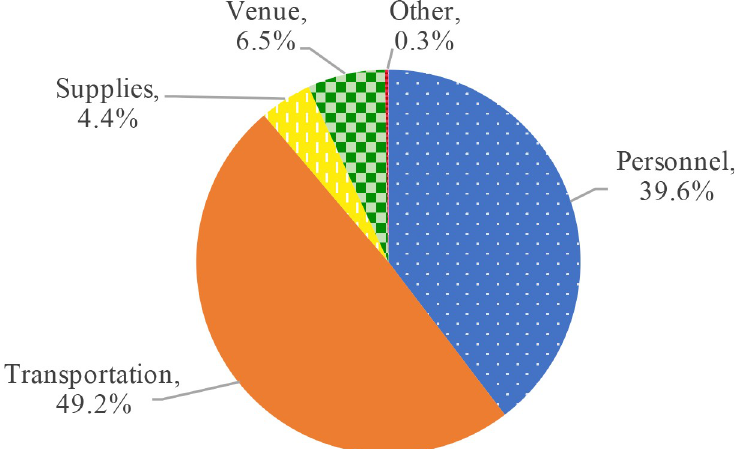
Fig 1. Proportion of total costs by input Category (for all activities) for trachoma impact and surveillance surveys rounds 1–8, Amhara, Ethiopia, 2012–2016.